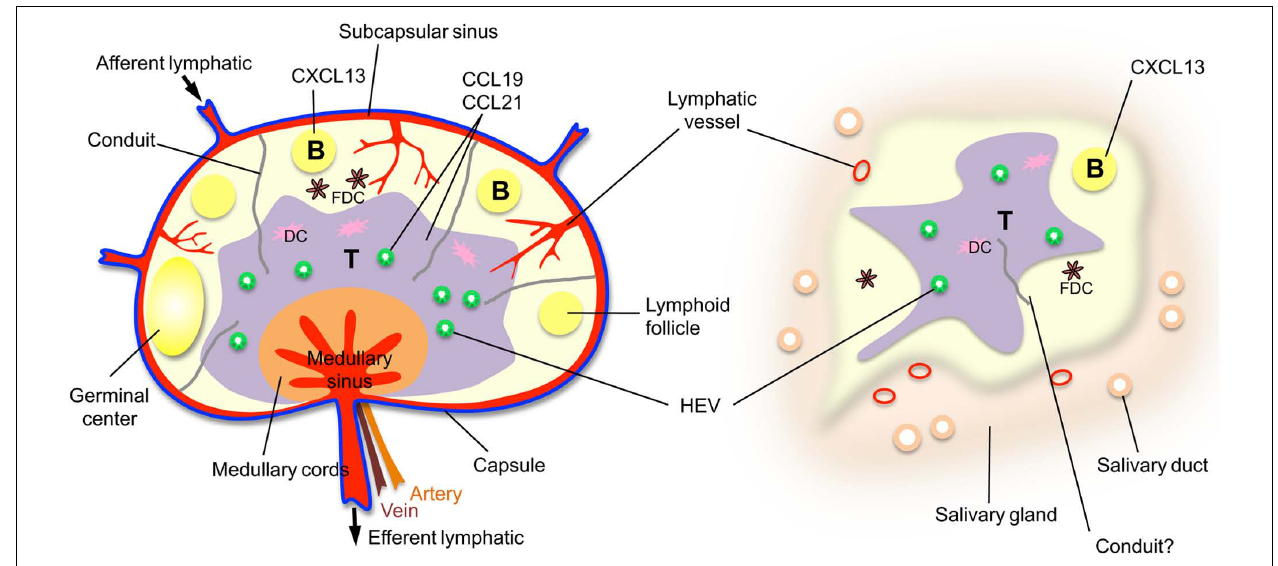
FIGURE 1 |A comparison of a lymph node with aTLO, a salivary gland from an individual with Sjögren’s syndrome. Note that the HEVs and lymphatic vessels are colored to indicate the existence of mice with green fluorescent HEVs (Bentley etal., 2011) and red fluorescent lymphatic vessels (Truman